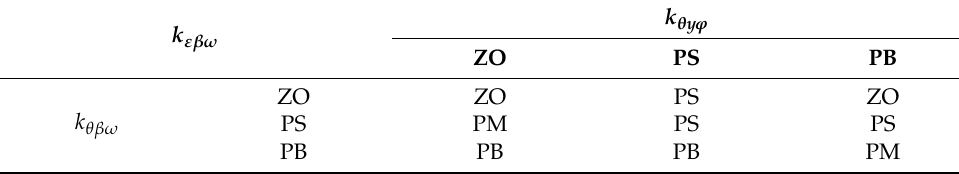
Table 2. Fuzzy rules of the dynamic stability weight ratio.